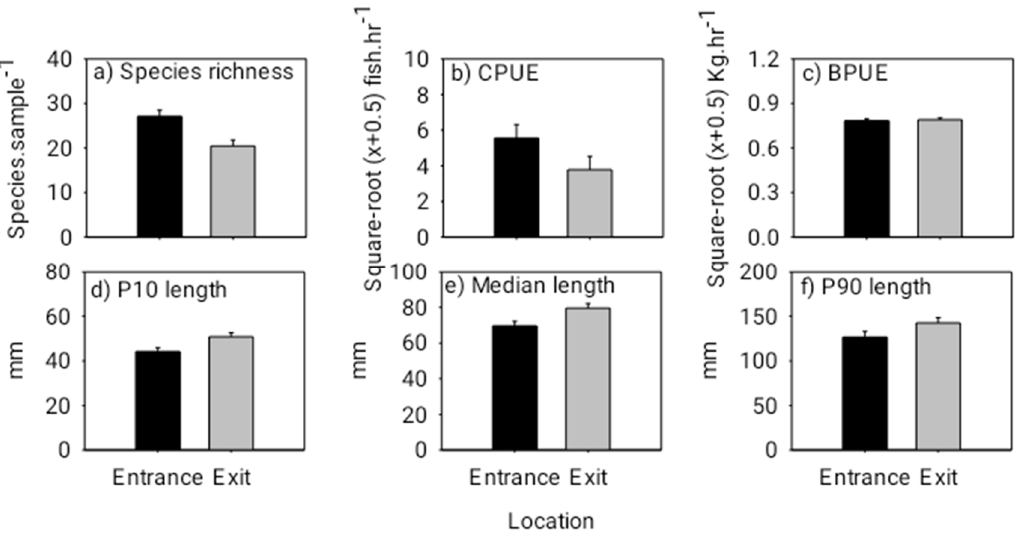
Figure 5. Mean (+ 1 SE) species richness (species sample − 1 ) ( a ), mean (+ 1 SE) abundance (CPUE in catch hour − 1 ) ( b ), mean (+ 1 SE) biomass (BPUE in kg hour − 1 ) ( c ), 10 th percentile (+ 1 SE) fish length ( d ), median (+ 1 SE) fish length ( e ) and 90 th percentile (+ 1 SE) fish length ( f ) (lengths pooled across all species) at the entrance and exit locations for the dusk/night experiment. Note, the black bars represent the entrance and the grey bars represent the exit. Additionally, square root (x + 0.5) transformed values have been presented for CPUE and BPUE to correspond with the ANOVA tests.